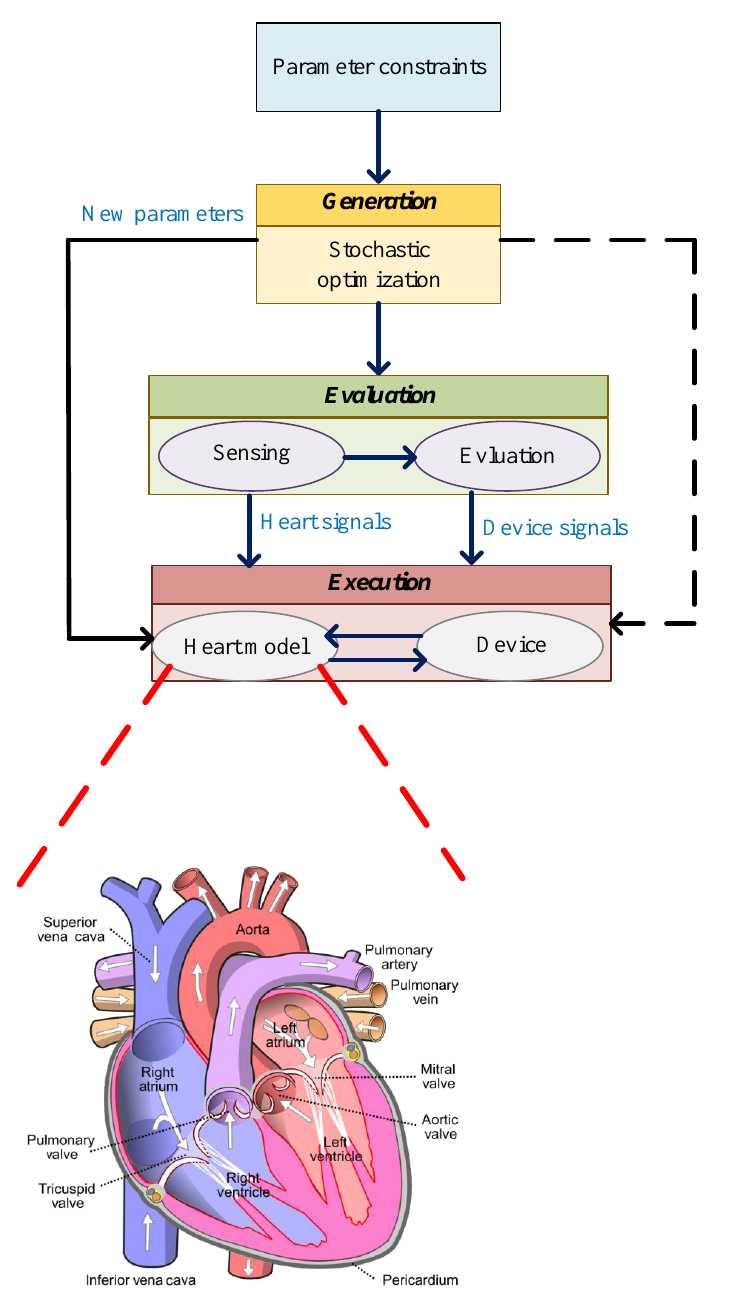
Figure 24. Closed-loop device based on the stochastic method with the illustration of a cardiac conduction network where circles shows the clusters of